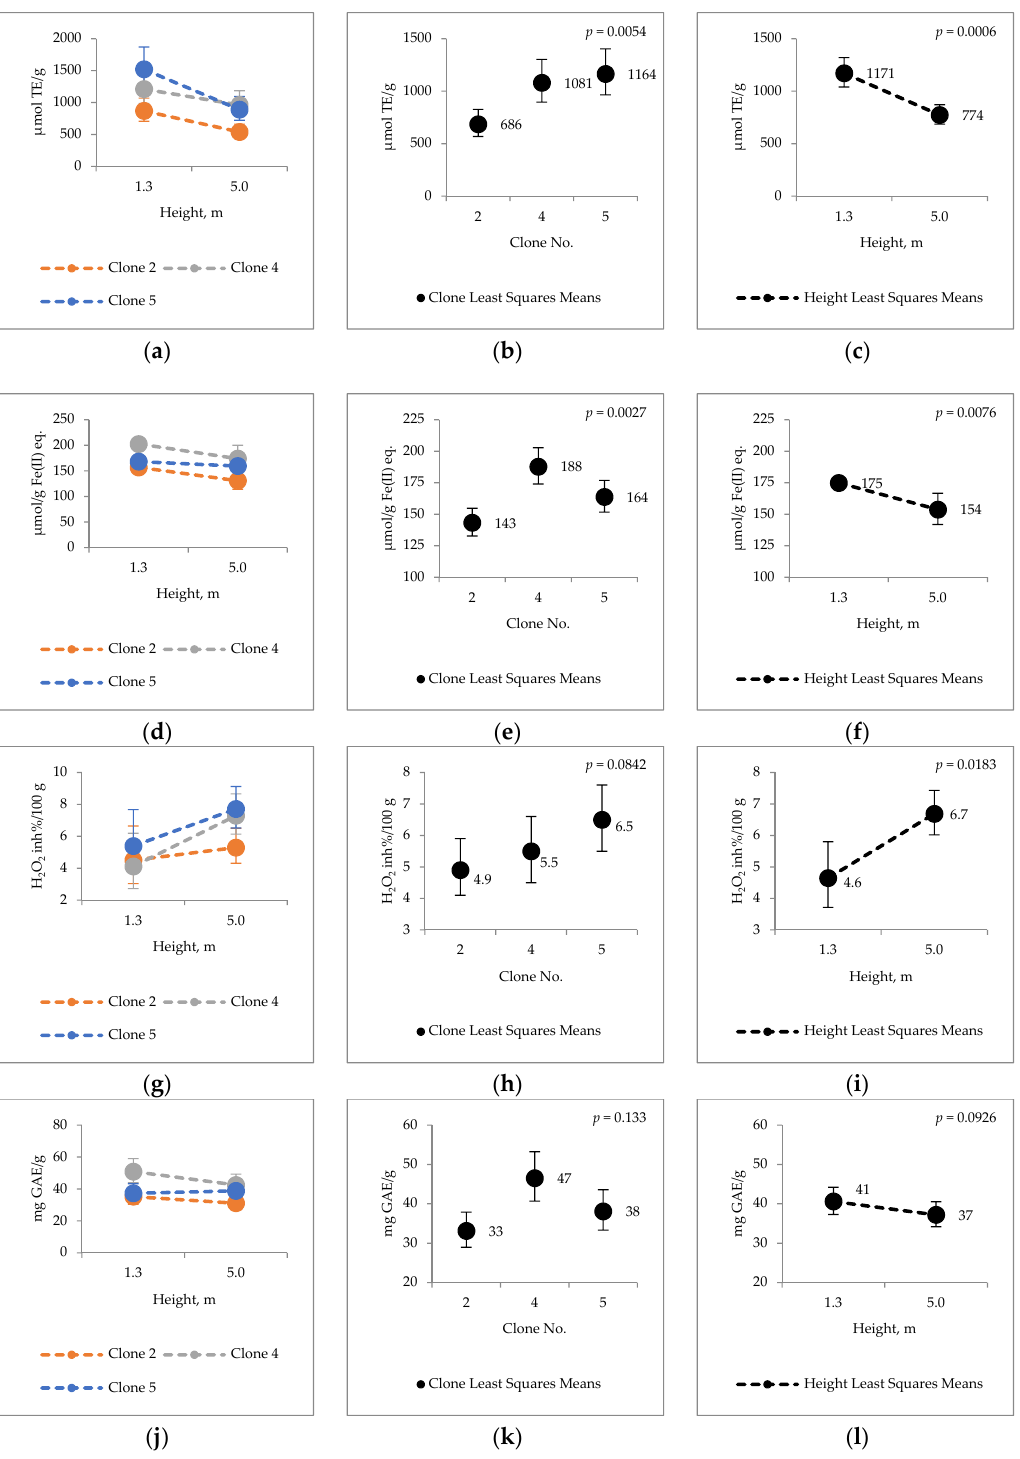
Figure 5. Ethanol extract antioxidative capacity ( a – c ) ORAC µmol TE/g; ( d – f ) FRAP µmol/g Fe(II) eq.; ( g – i ) H 2 O 2 scavenging H 2 O 2 inh % per 100 g; ( j – l ) Total phenolic content mg GAE/g.